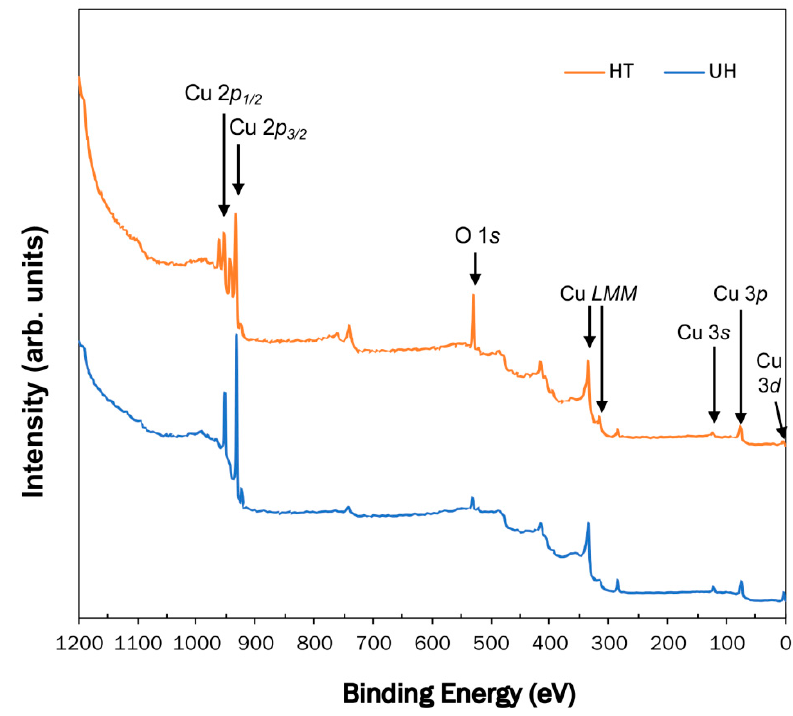
Figure 3. X-ray photoelectron spectroscopy (XPS) wide-scan spectra of the unheated Cu plate (UH) and heated Cu plate (HT).